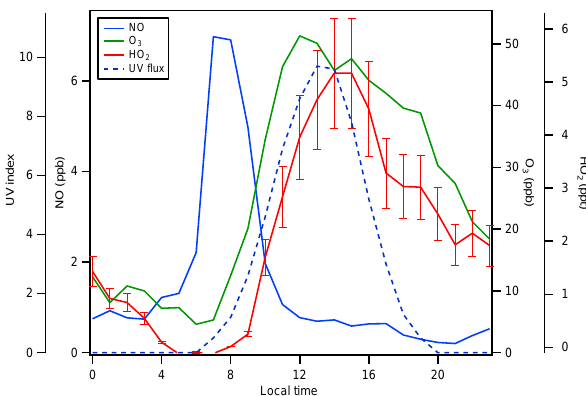
Figure 4. Hourly median diurnal profiles of HO 2 , NO, O 3 and UV index in Atlanta. The sampling period was during 9 June 2015 21:14:00 to 11 June 2015 13:28:00, and 15 June 2015 01:52:00 to 25 June 2015